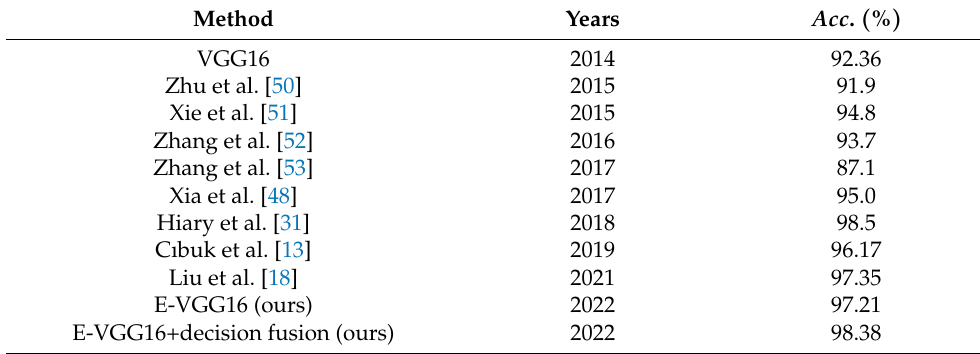
Table 6. Comparisons with the state-of-the-art methods on Oxford